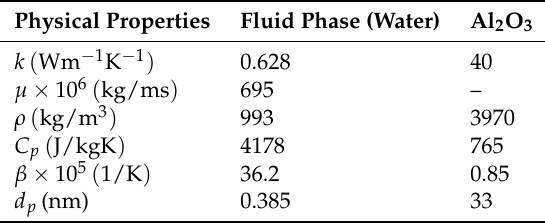
Table 1. Thermo-physical properties of water with Al 2 O 3 nanoparticles at T = 310 K